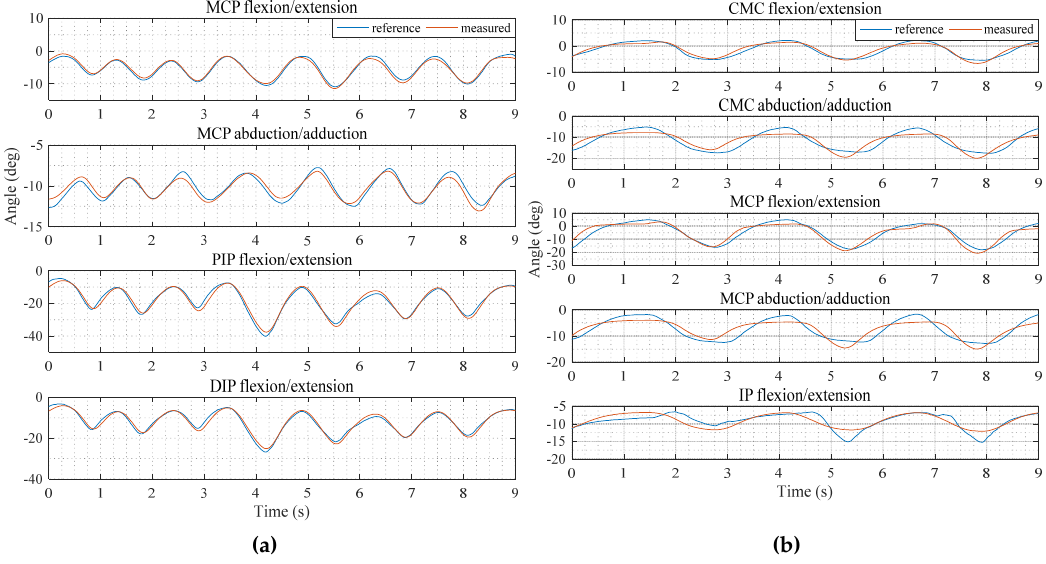
Figure 15. Comparison of the joint angles with MoCap data: ( a ) Comparison for the index finger; ( b ) Comparison for the thumb